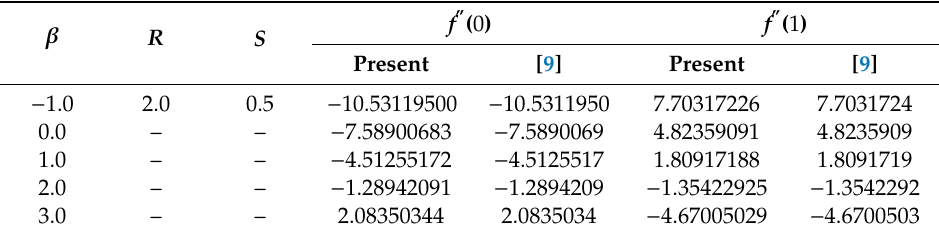
Table 2. Comparison with existing literature for φ = 0, M =